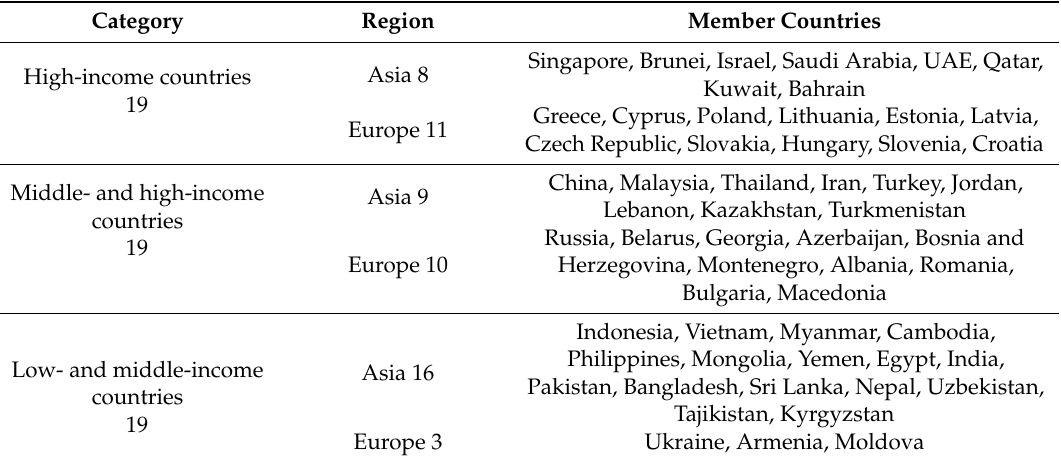
Table 1. Countries in the “Belt and Road Initiative